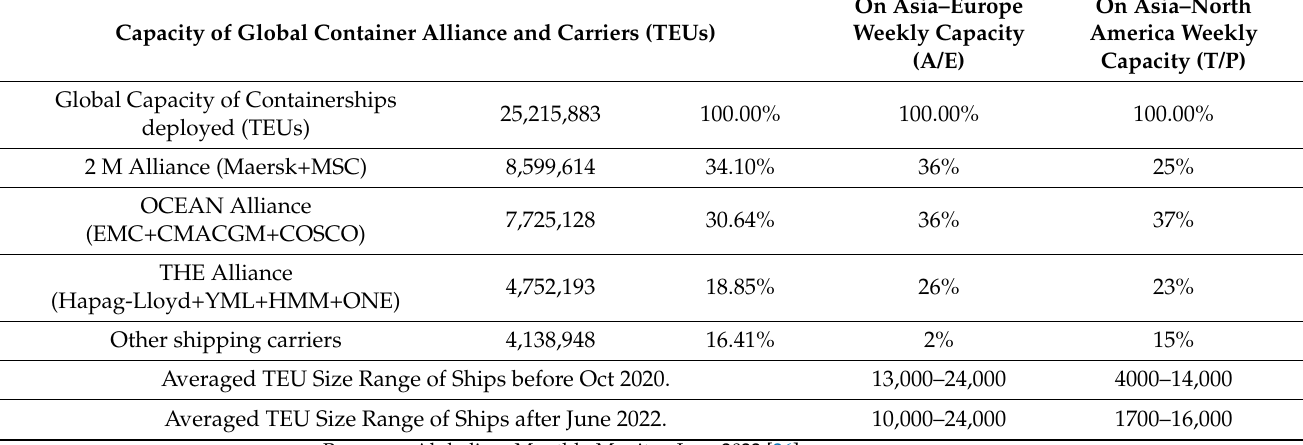
Table 3. The capacity of container alliance and carriers on East–West trunk